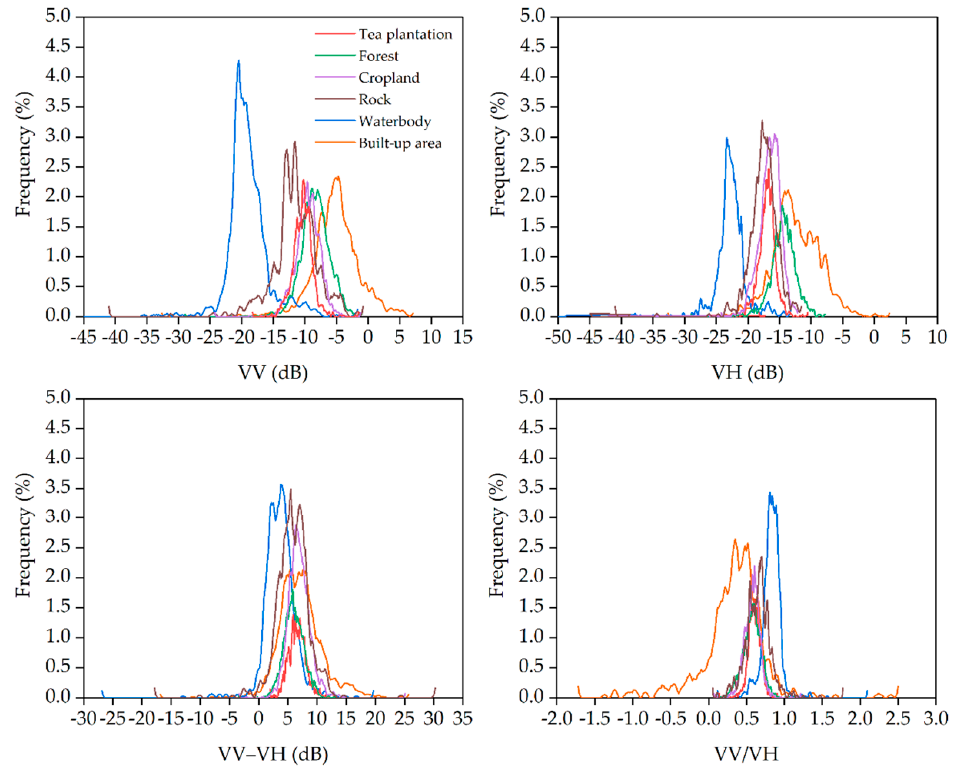
Figure 5. Sentinel-1A data profiles of six land cover types in the study area. VV: vertical transmit and vertical receive; VH: vertical transmit and horizontal receive.